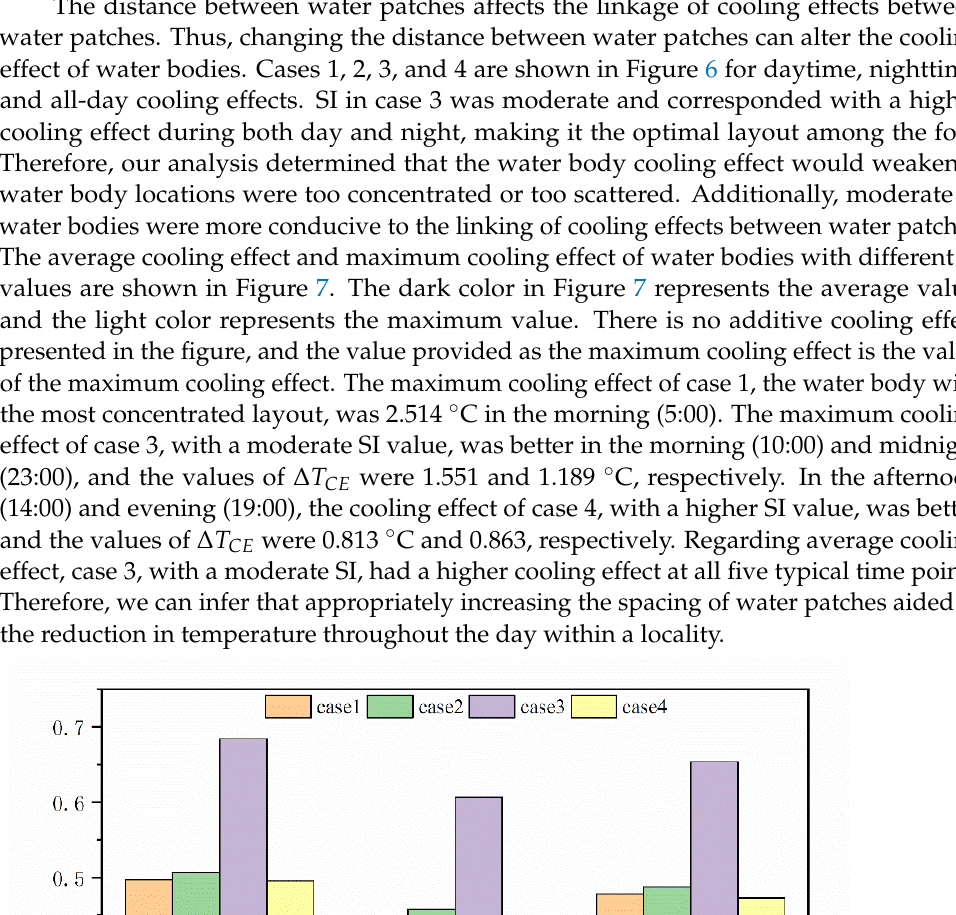
Figure 7. Average cooling effect and maximum cooling effect of cases 1, 2, 3 and 4. The temperature distribution of cases 1, 2, 3, and 4 at 14:00 is shown in Figure 8. We defined the blue area as the lowest ‐ temperature area, the green and yellow areas as low ‐ temperature areas, the orange and red areas as high ‐ temperature areas, and the purple area as the highest ‐ temperature area. From Figure 8, we can see that a moderate SI was more likely to reduce the temperature in the interstitial regions between water patches and had more cooling advantages for the whole location. As SI increased, the lowest ‐ tem ‐ perature region (blue) and the low ‐ temperature region (green) gradually separated. How ‐ ever, the cooling effect linkage between the water patches caused the separated interstitial area to be filled by the next ‐ lowest temperature region (yellow). When the SI was too high,